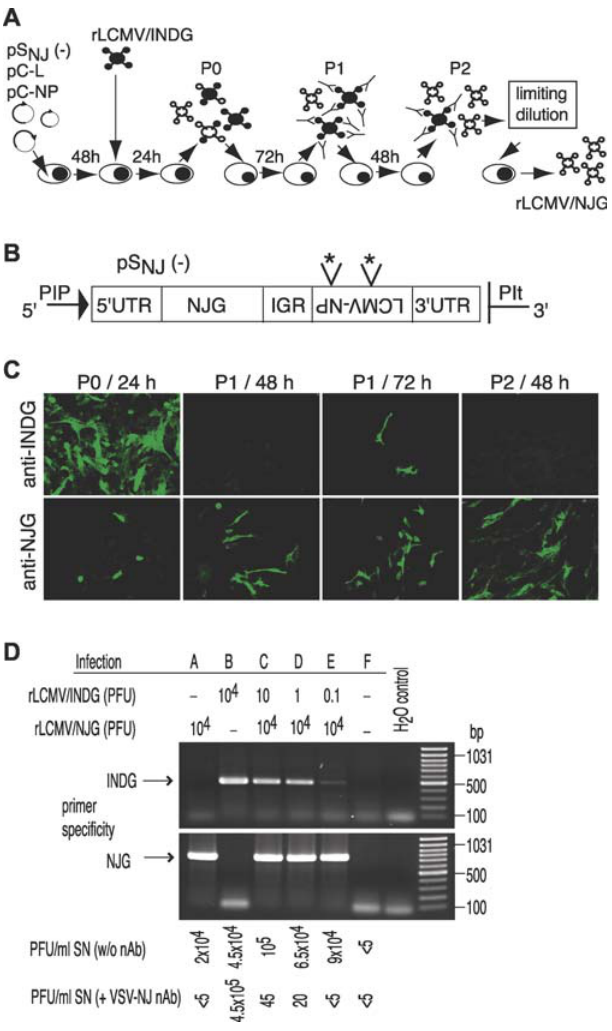
Figure 4. Generation and Characterization of